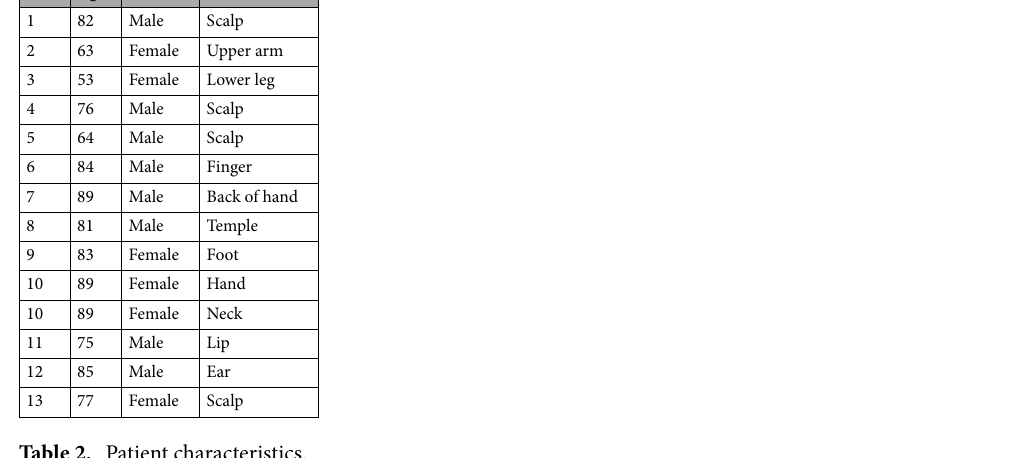
Table 2. Patient characteristics.